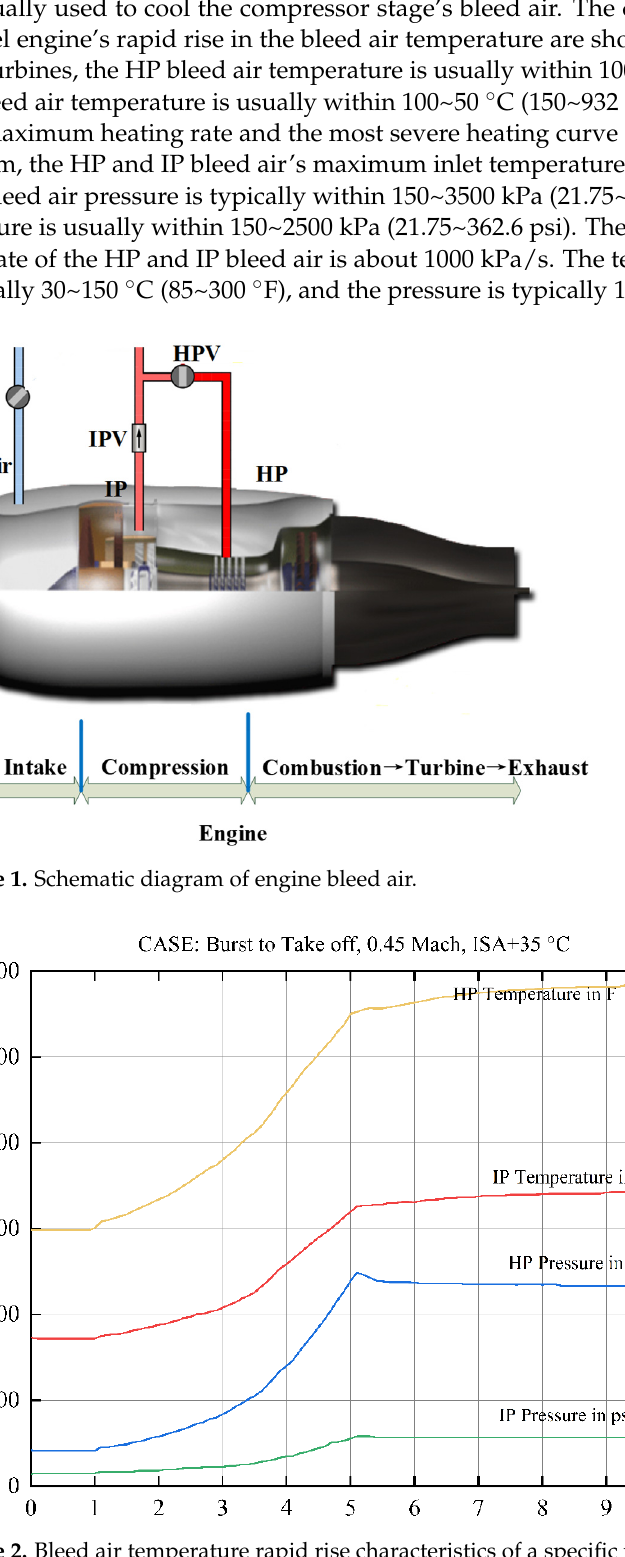
Figure 2. Bleed air temperature rapid rise characteristics of a specific model engine.